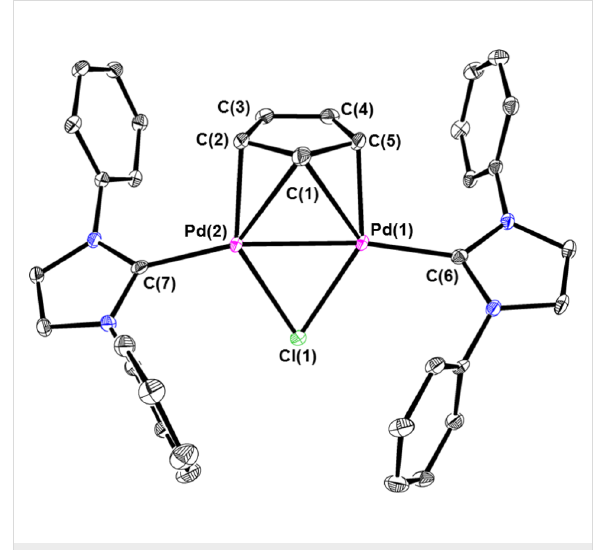
Figure 4: ORTEP of Cp Dim at 30% probability. Hydrogen atoms and isopropyl groups of IPr are omitted for clarity. Selected bond